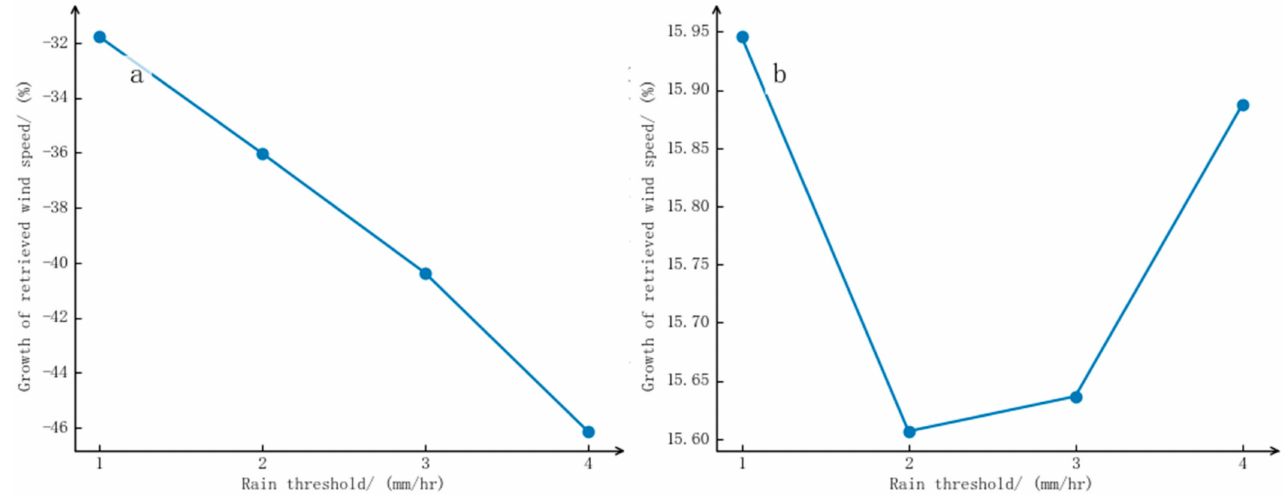
Figure 7. Influence of HY2RRM 0.5 model on accuracy of retrieved wind speed with rain threshold. ( a ) The result of rain-contaminated data; ( b ) the result of rain-free data.